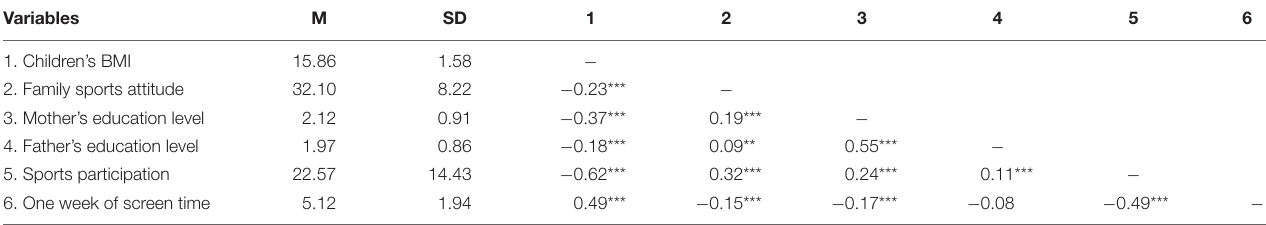
TABLE 3 | Analysis of the correlation among family sports attitude, parents’ education levels, sports participation, screen time, and children’s BMI ( N = 589). Variables M SD 1 2 3 4 6